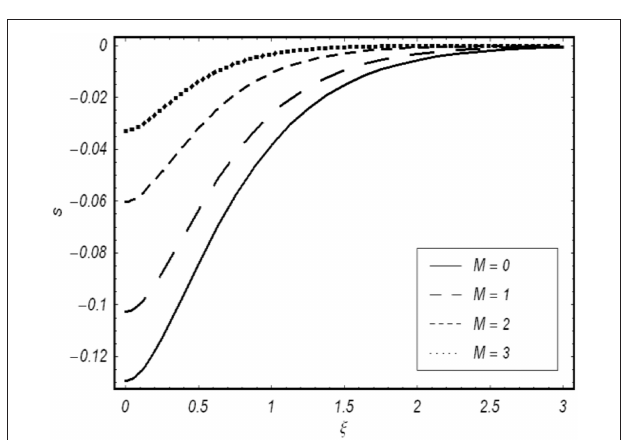
FIGURE 7 | Shear stress plots showing variations in K (Newtonian fluid).